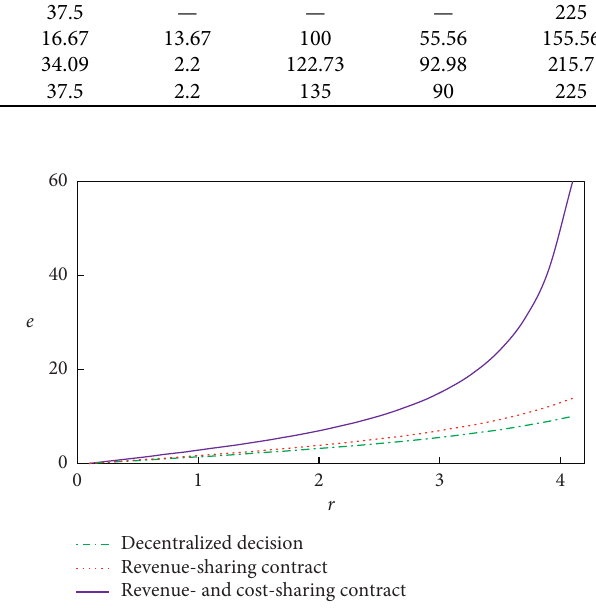
Figure 3: Impact of consumers’ occupational health and safety sensitivity coefficient on work safety.